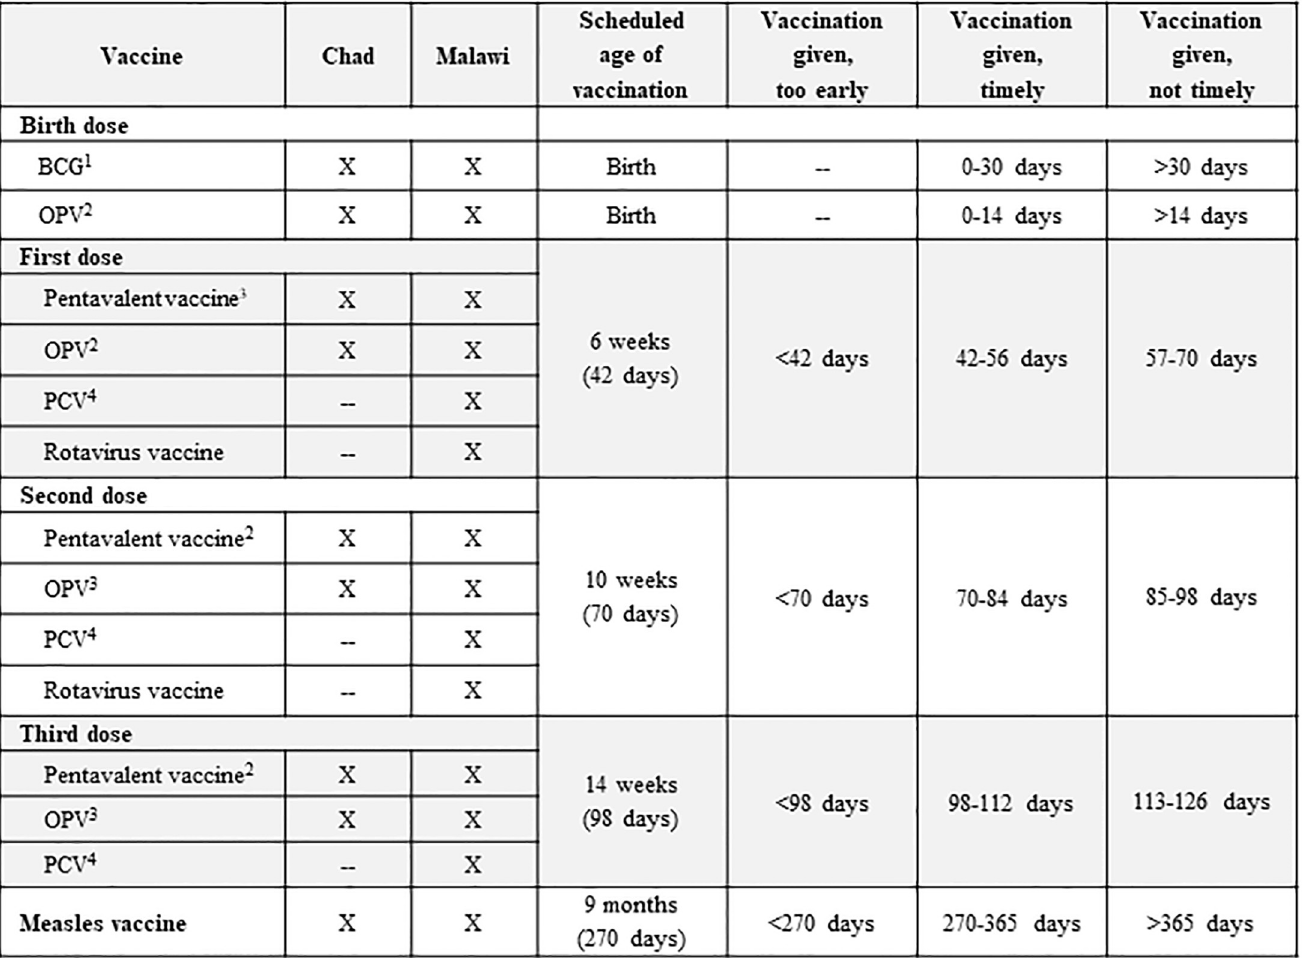
Fig 3. Time intervals used for classifying timeliness of vaccination doses received by surveyed children, using the nationally recommended ages for vaccination: Chad and Malawi, 2015. 1 bacille Calmette-Guerin (BCG) vaccine. 2 Oral poliovirus vaccine (OPV). 3 Diphtheria-tetanus-pertussis-hepatitis B- Haemophilus influenzae type b vaccine (pentavalent) vaccine. 4 Pneumococcal conjugate vaccine (PCV).